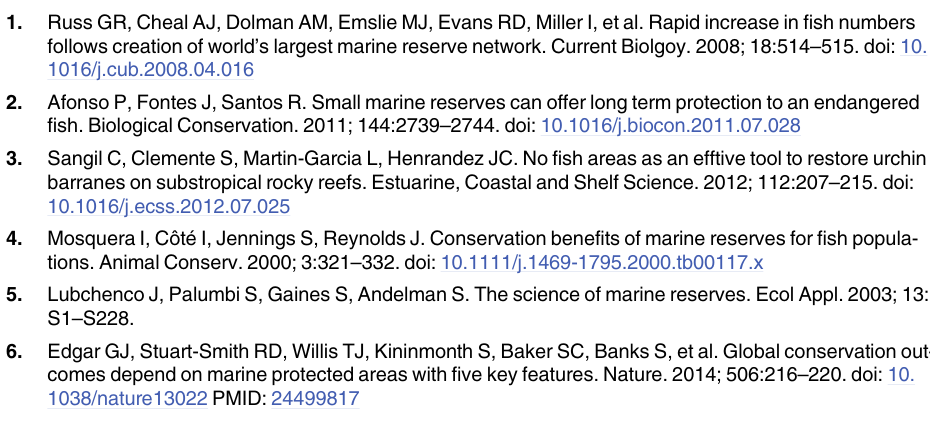
S1 Fig. Estimates for the coefficients in the Spatial Model. Posterior means and accompa- nying 95% credible intervals. S2 Fig. Prior and posterior for the effective range, 3/ ϕ , and spatial variance, σ 2 , in meters. S3 Fig. Parameter estimates under the five subsets in the Non-Spatial k-fold cross valida- tion. Posterior means and accompanying 95% credible intervals. S4 Fig. Parameter estimates under the five subsets in the Spatial k-fold cross validation. Posterior means and accompanying 95% credible intervals. S5 Fig. Spatial parameter estimates for σ 2 and ϕ under the five subsets in the k-fold cross validation. Posterior means and accompanying 95% HPD credible